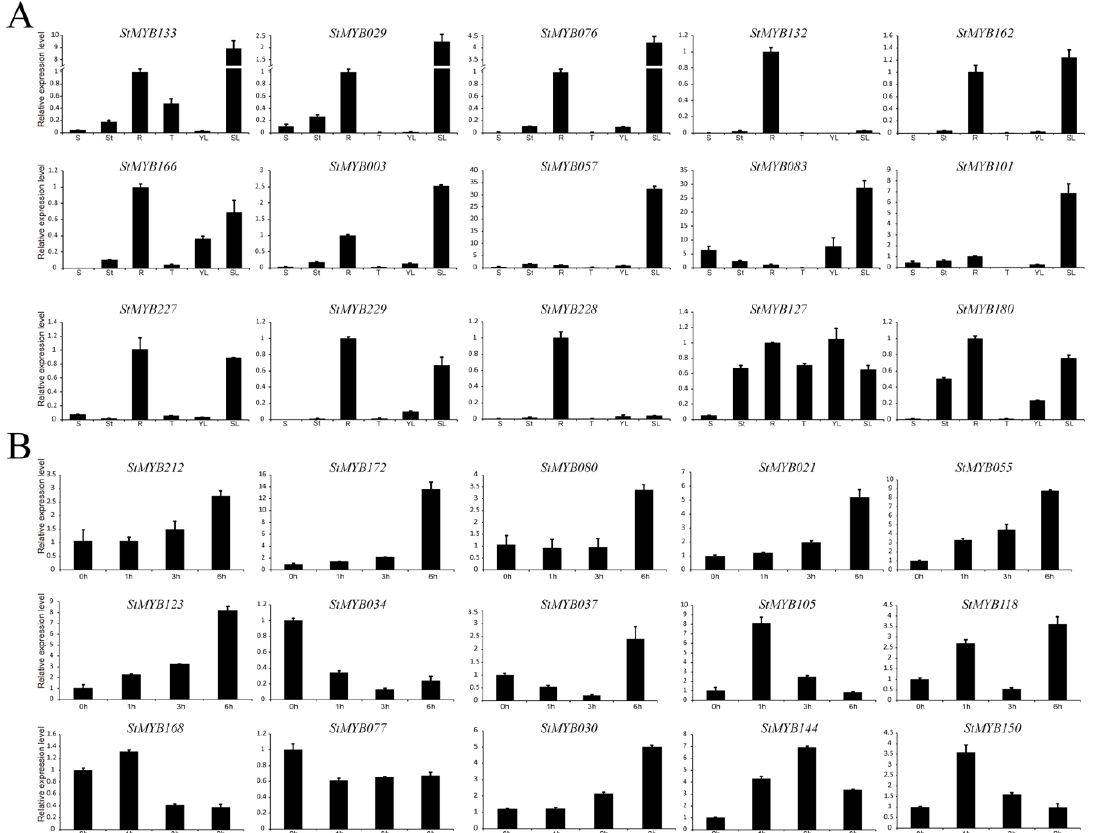
Figure 9. The expression patterns of selected StMYB genes detected by qRT-PCR. ( A ) To confirm the tissue specificity, the expression pattern of the selected StMYB genes was calculated as folds relative to the expression level of the root. ( B ) The expression pattern of selected StMYB genes in response to salt stress treatments, which was calculated as folds relative to the untreated control.